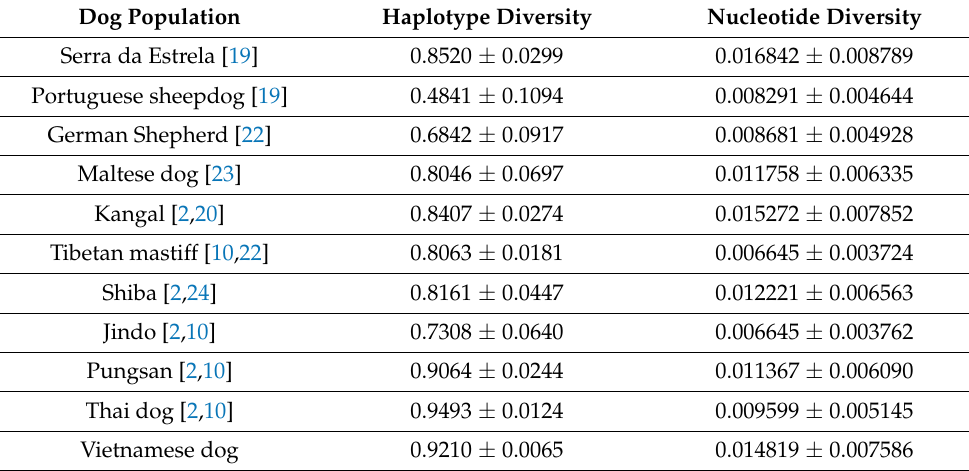
Table 2. Haplotype diversity and nucleotide diversity of examined dog